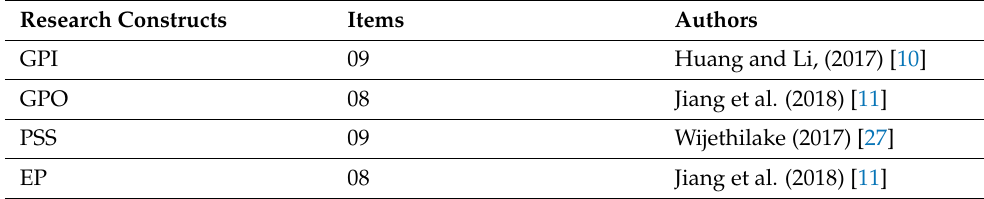
Table 1. Summary of Research Constructs.